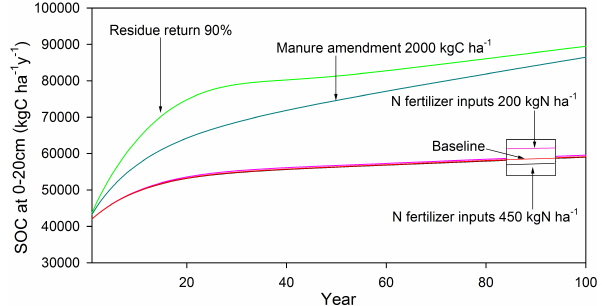
Fig. 8. Influence of management practices on long-term SOC con- tent.